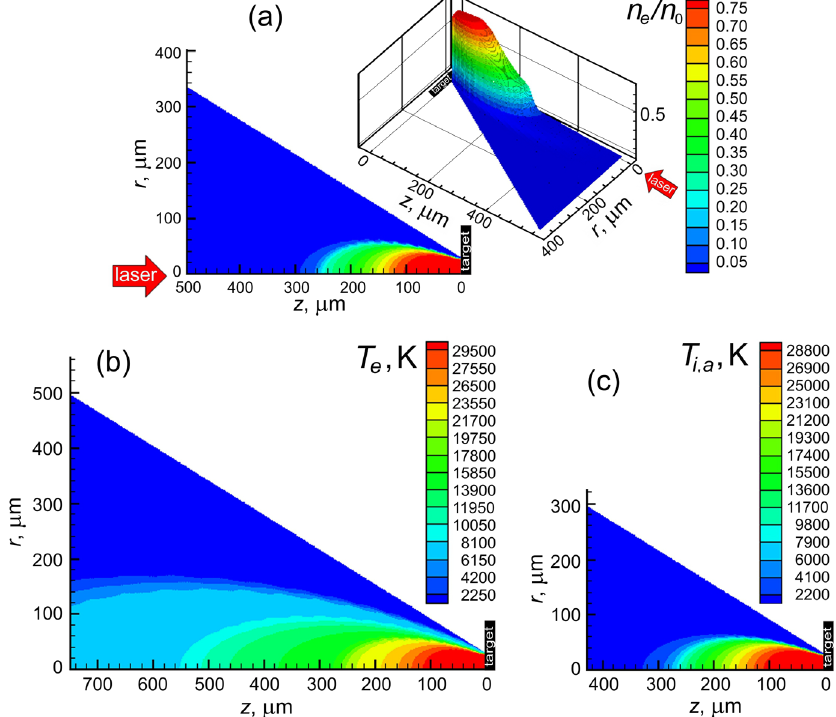
Figure 5. ( a ) Calculated distribution of the ionization degree of air in front of an aluminum target at 1 ns after irradiation for the experimental conditions of work [37]. r and z are the radius counted from the laser beam axis and the distance from the target in air, respectively. Laser wavelength is 800 nm; pulse duration is 50 fs; fluence is 40 J/cm 2 . For a clearer representation, the distribution is given as a contour map and 3D surface. ( b , c ) present the spatial distributions of the electron and molecule (both neutral and ionized) temperatures for the conditions shown in ( a ). Time moment is 1 ns after